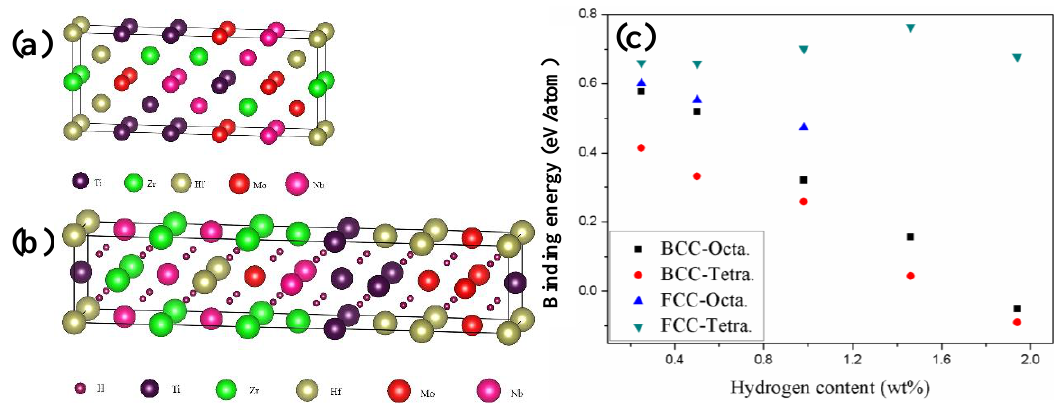
Figure 5. (Color online) The BCC atomic model before hydrogenation ( a ) and the hydrogenated FCC atomic model ( b ). ( c ) Variation of the binding energy for the BCC and FCC hydrogenated TiZrHfMoNb with the H content. (Octa.: octahedral occupation for H; Tetra.: Tetrahedral occupation for H.)